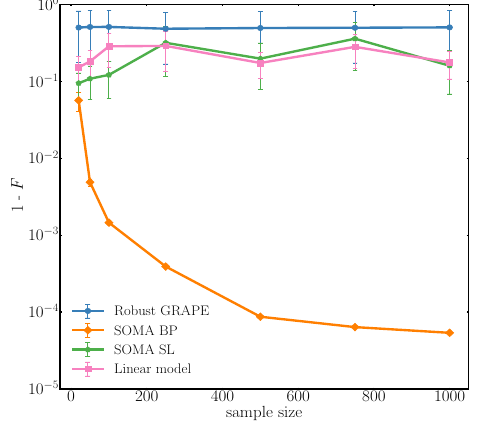
FIG. 8. An example of the average performance (1000 test samples) of robust GRAPE, SOMA SL, SOMA BP, and the linear model as a function of the number of (training) systems sampled for the single-qubit R 2 (θ) gate with the same parame- ters as in Fig. 5. We observe here how in this case, the average infidelity in SOMA BP decreases as a function of the sample size, whereas the other methods show little to no